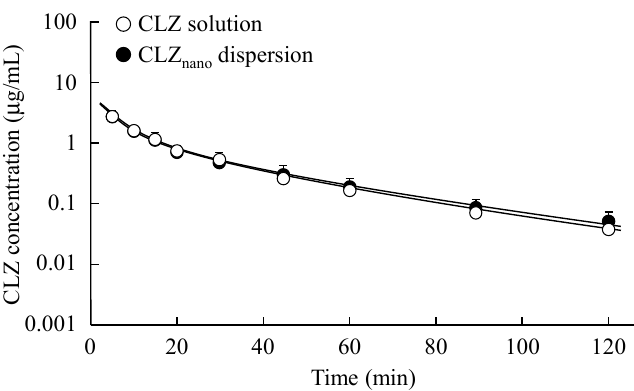
Figure 3. Changes in plasma CLZ concentration after intravenous injection of CLZ solution or CLZ nano dispersion. 0.3 mL of CLZ solution (open circles) or CLZ nano dispersion (closed circles) was injected into the femoral vein (0.1 mg/kg), and venous blood (200 μ L) was collected. Solid lines present fitting curves for plasma CLZ fates after intravenous administration of CLZ solution or CLZ nano dispersion. The data are presented as means ± S.E. of seven independent rats.